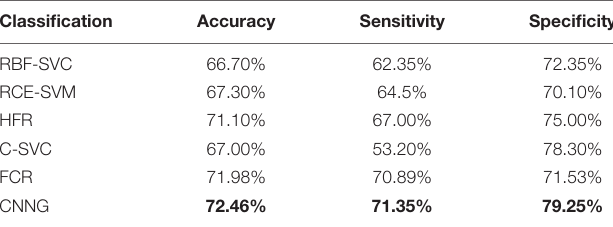
TABLE 7 | Classification performance of traditional machine learning algorithms and CNNG. Classification